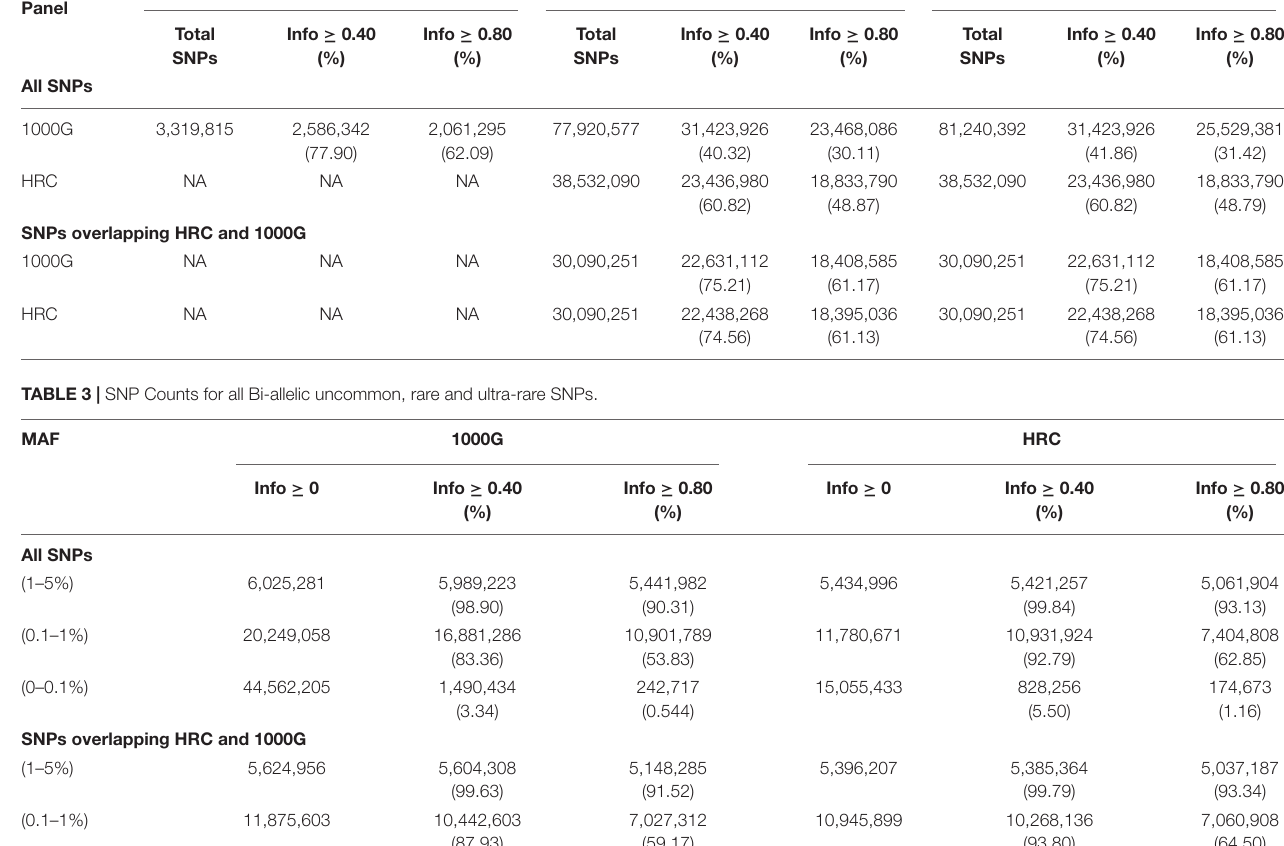
TABLE 2 | Type of imputed SNPs across reference panels. Reference